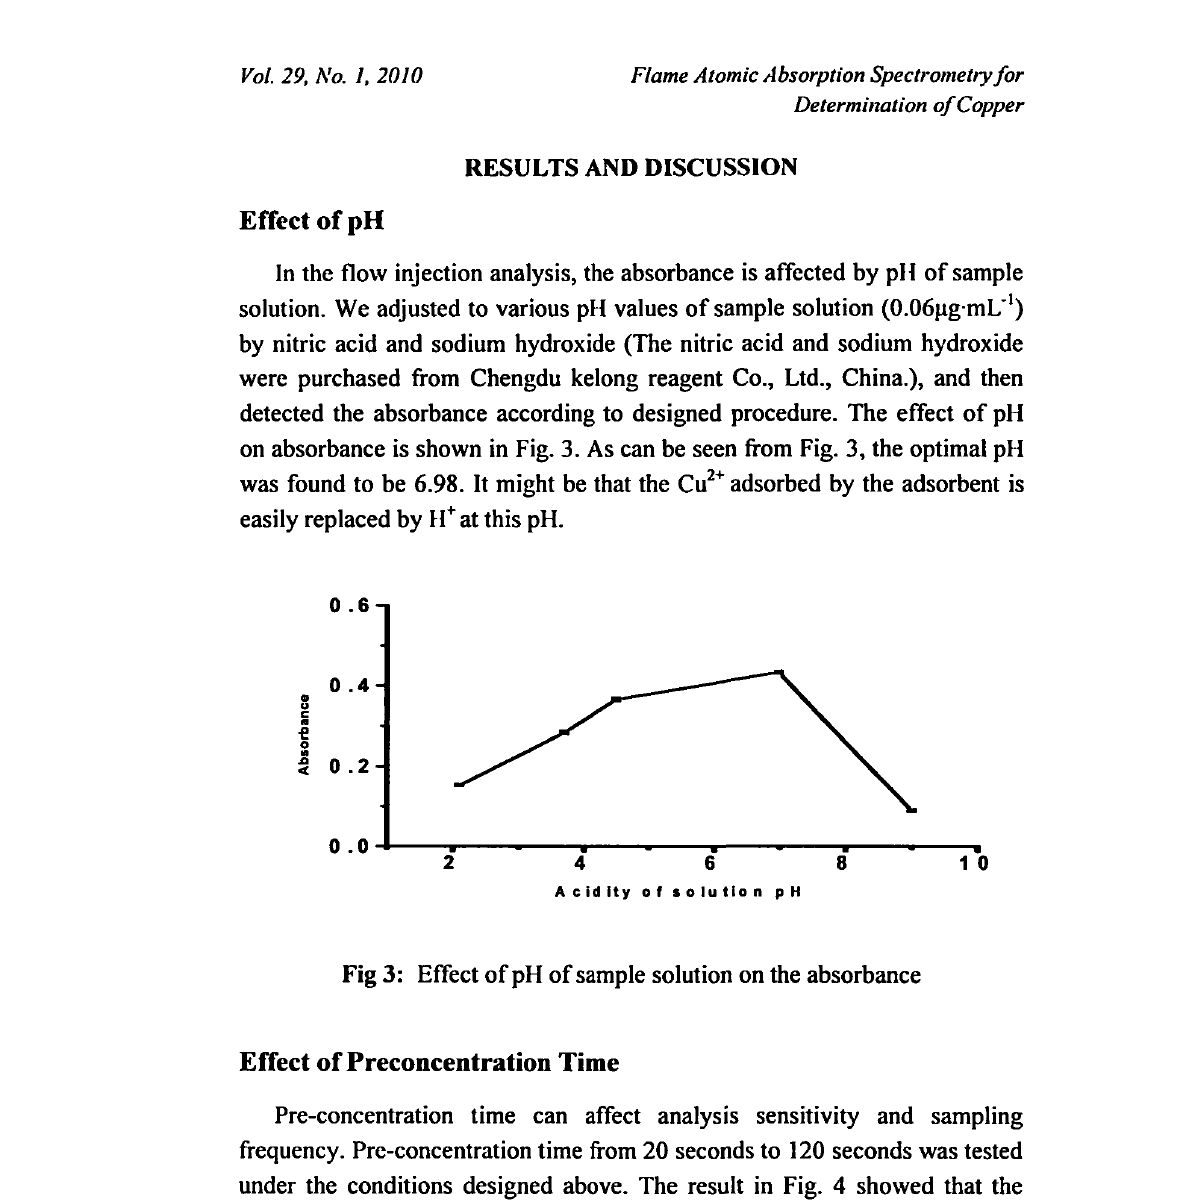
Fig 3: Effect of pH of sample solution on the